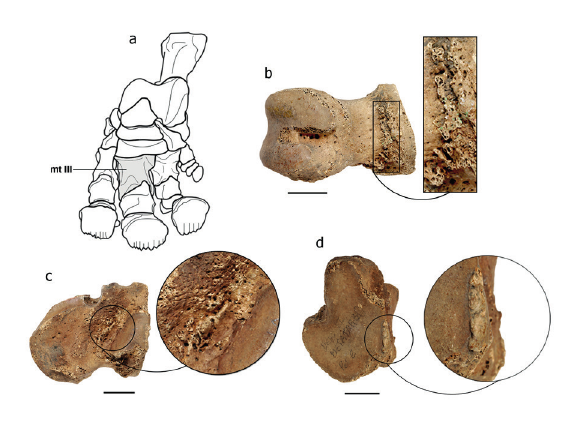
Figure 3 - ( a ) scheme of the foot of Panochthus sp. (modified from Burmeister, 1874); ( b ) left ectocuneiform (MN 3734-V) in lateral view with highlight of the lesion. Scale bar = 2.0 cm. Abbreviation: ec: